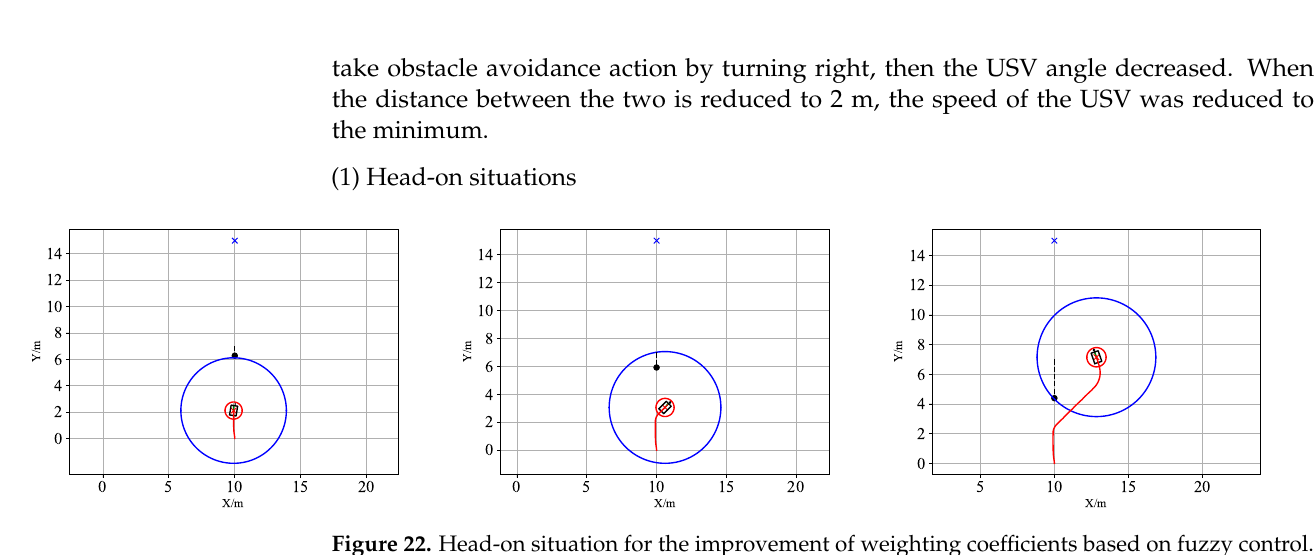
Figure 22. Head-on situation for the improvement of weighting coefficients based on fuzzy control.